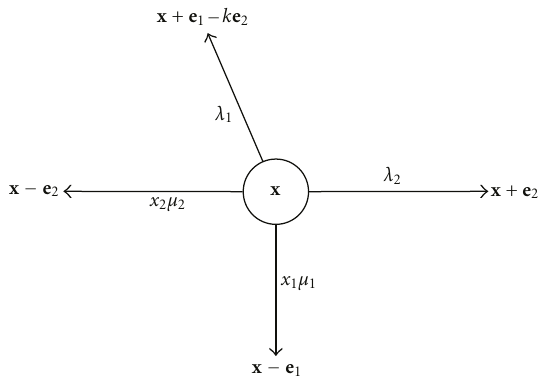
Figure 1: State transition rates of the CTMC from a generic state x ∈ S